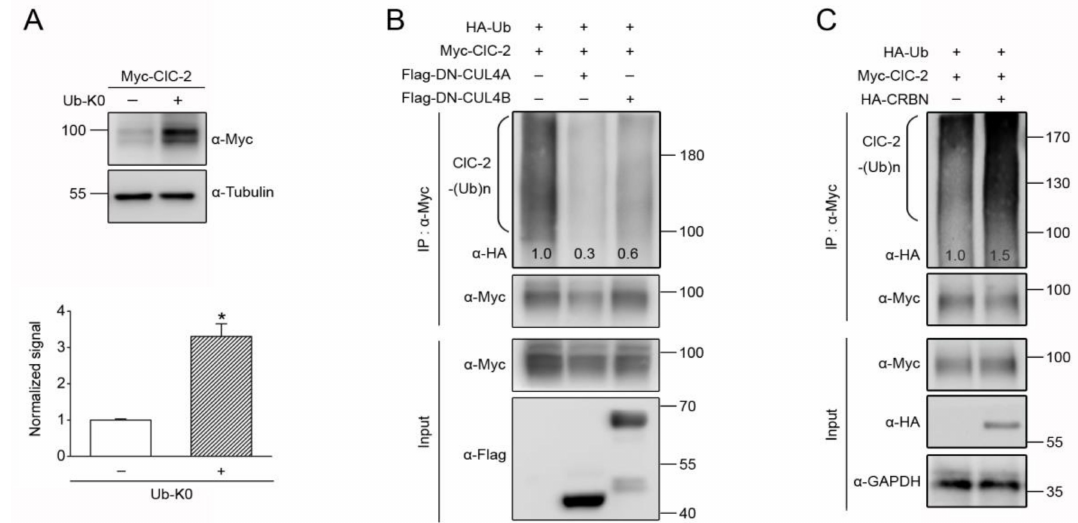
Figure 4. CUL4 E3 ligase promotes polyubiquitination of ClC-2 channels. ( A ) ( Upper panel ) Representative immunoblots showing the e ff ect of the 24-h treatment of HA-tagged lysine-less ubiquitin (HA-Ub-K0) co-expression on the protein expression of Myc-ClC-2 in HEK293T cells. ( Lower panel ) Quantification of the relative ClC-2 protein levels. Protein density was standardized as the ratio of the ClC-2 signal to the cognate tubulin signal. Value from the Ub-K0 co-expression group ( hatched bar ) was then normalized to those for the vector control ( clear bar ). Asterisks denote a significant di ff erence from the control (*, t test: p < 0.05; n = 5). ( B , C ) Representative immunoblots showing the e ff ect of Flag-DN-CUL4A / B ( B ) or HA-CRBN ( C ) co-expression on ClC-2 polyubiquitination (ClC-2-(Ub)n) by HA-tagged ubiquitin (HA-Ub). Co-expression with the Flag / HA vector was used as the control experiment. The numbers shown on the immunoblot denote densitometric quantification of the relative ClC-2 ubiquitination with respect to the vector control. Cell lysates were immunoprecipitated (IP) with α -Myc / Flag, and protein ubiquitination was recognized by immunoblotting the immunoprecipitates with α